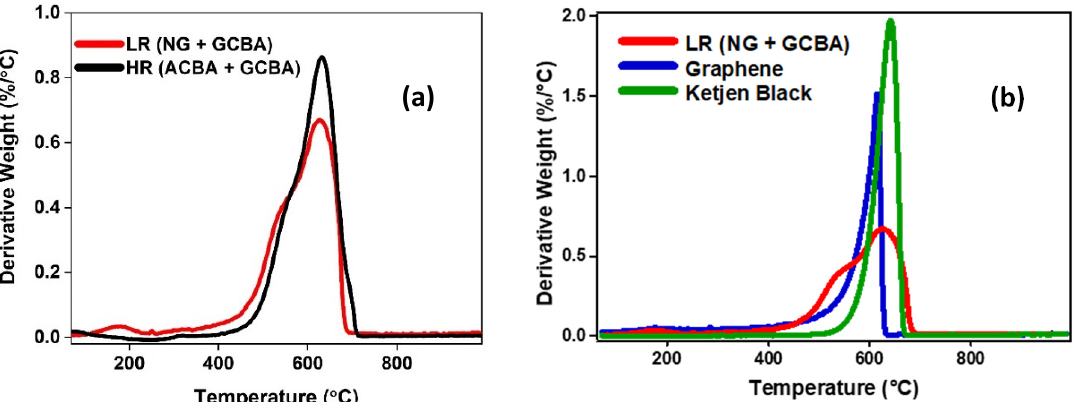
Figure 3. ( a ) Derivative TGA plots for carbon produced at low (LR) and high (HR) ratio of methane to argon, and ( b ) comparison of LR produced carbon with standard samples.